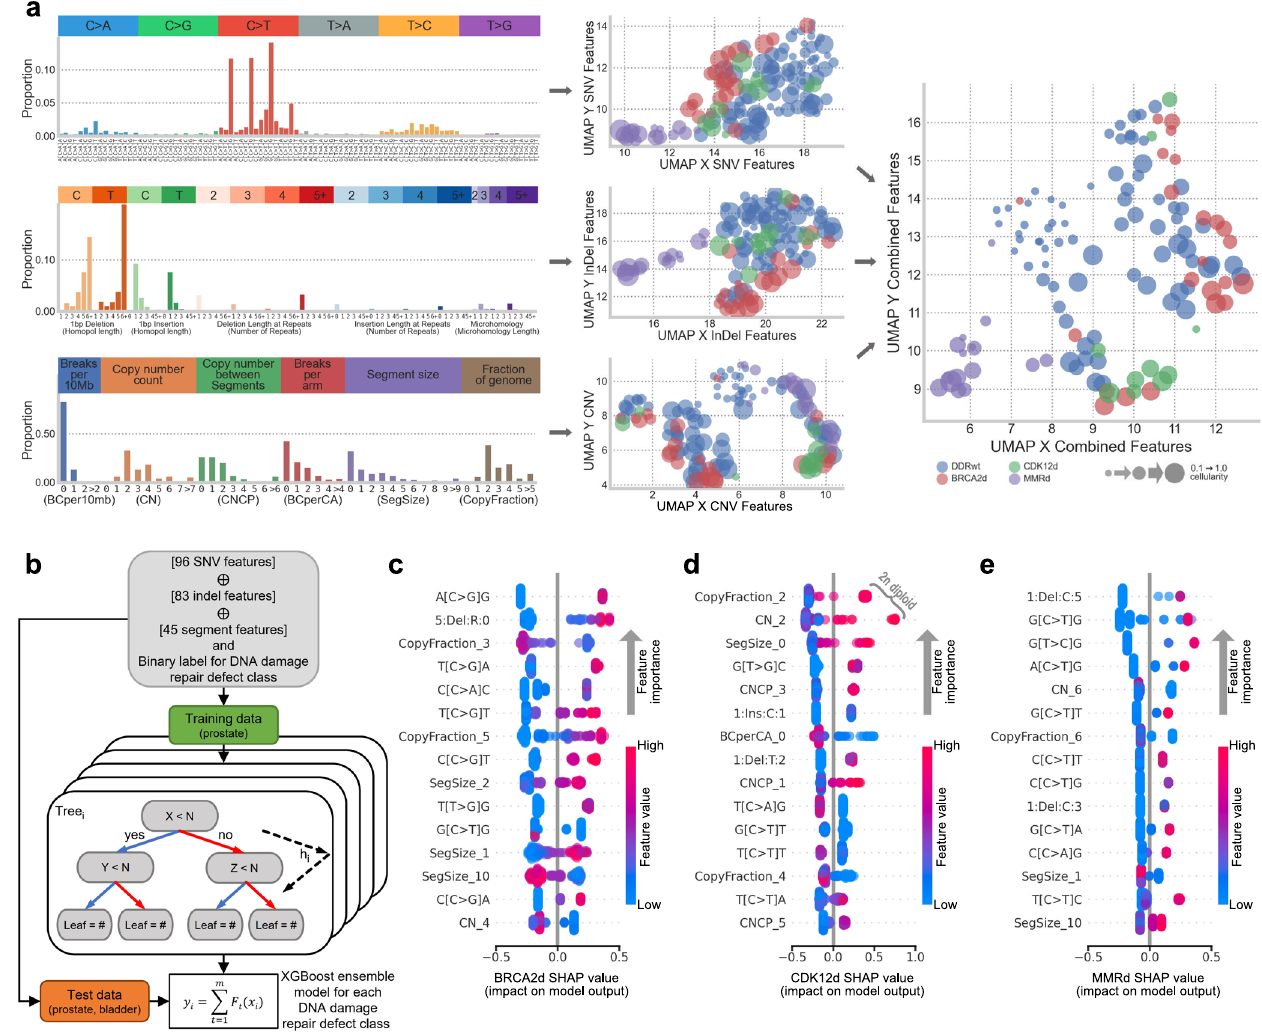
Fig. 2 The impact of combined or individual genomic features on classi fi cation of DNA damage repair defects. a Left, The 224 total genomic features that formed the input for the machine learning classi fi cation model (top = single nucleotide variants (SNVs), middle = insertion deletion variants (InDels), bottom = copy number variants (CNVs)). See “ Methods ” for feature breakdown. Bars represent the average proportions across all prostate cancer samples. a middle, 2 dimensional UMAP representation of each feature category, coloured by DNA damage repair gene label. a right, UMAP representation of all feature categories horizontally concatenated together. b Schema of XGBoost model generation. All genomic features from samples with metastatic prostate cancer are horizontally concatenated as the model inputs, followed by a process of training many iterations to produce ensemble models for each class of DNA damage repair defect. The models were tested on both metastatic prostate and bladder cancer samples. b – e SHapley Additive exPlanations (SHAP) summary plots illustrating the 15 most impactful features for each classi fi cation model. Impact is determined as the sum of each feature ’ s sample level SHAP value. Feature values (blue to pink gradient) are normalised as a proportion of the highest value of each respective